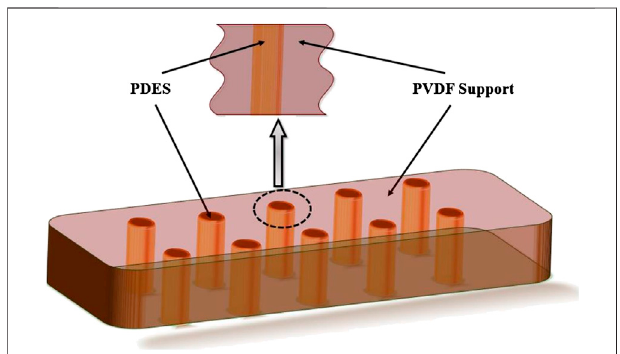
FIGURE 1 | Schematic representation of